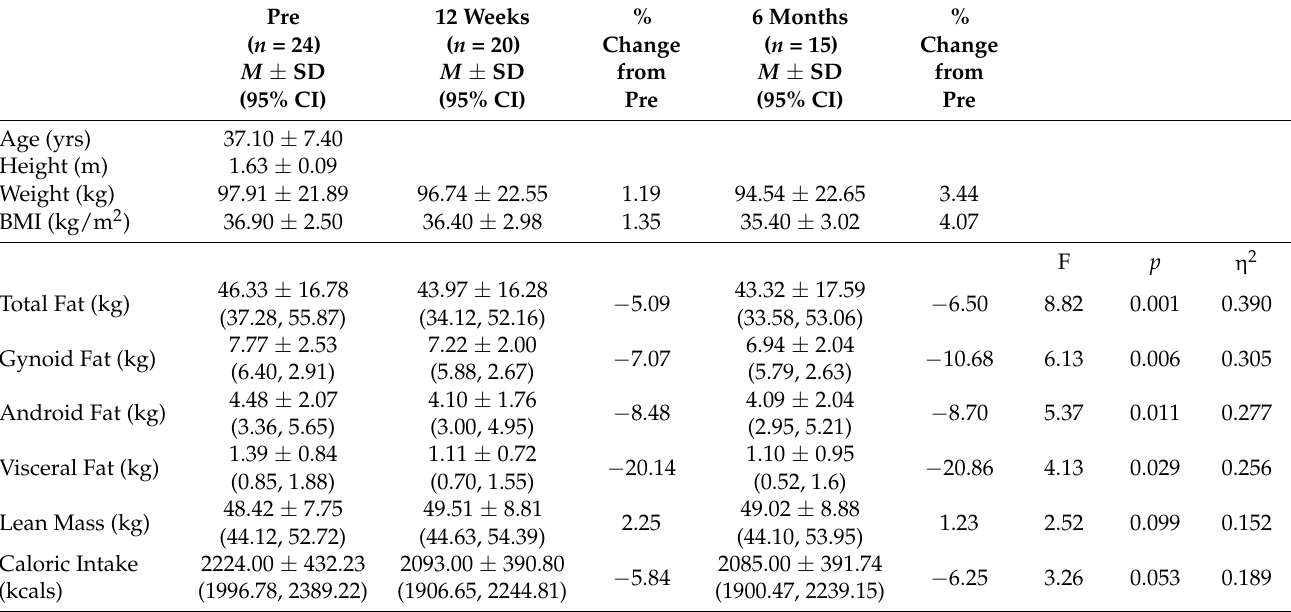
Table 1. Demographics and Body Composition